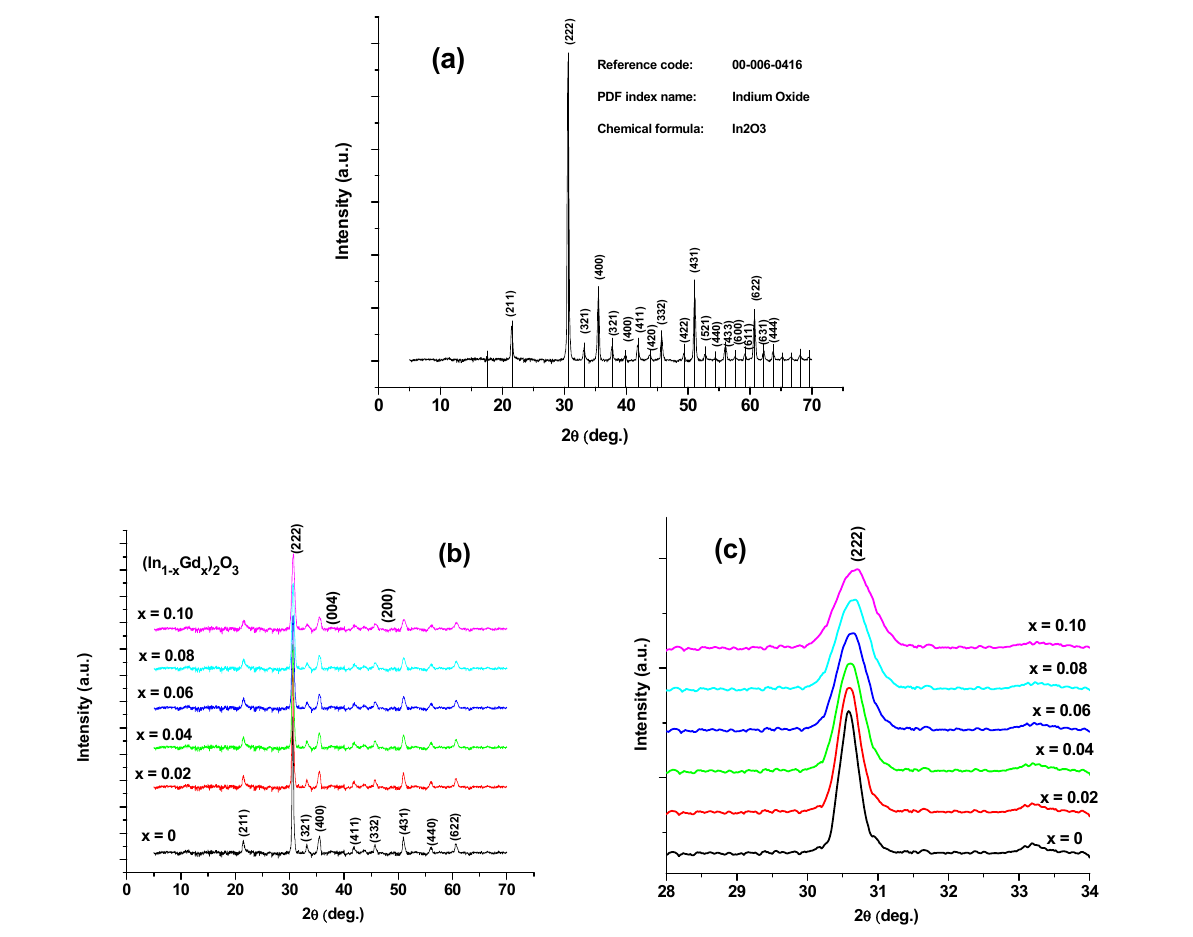
Figure 2. XRD of ( a ) In 2 O 3 powder, ( b ) (In 1 − x Gd x ) 2 O 3 thin films, and ( c ) amplification of XRD peaks with index (222).